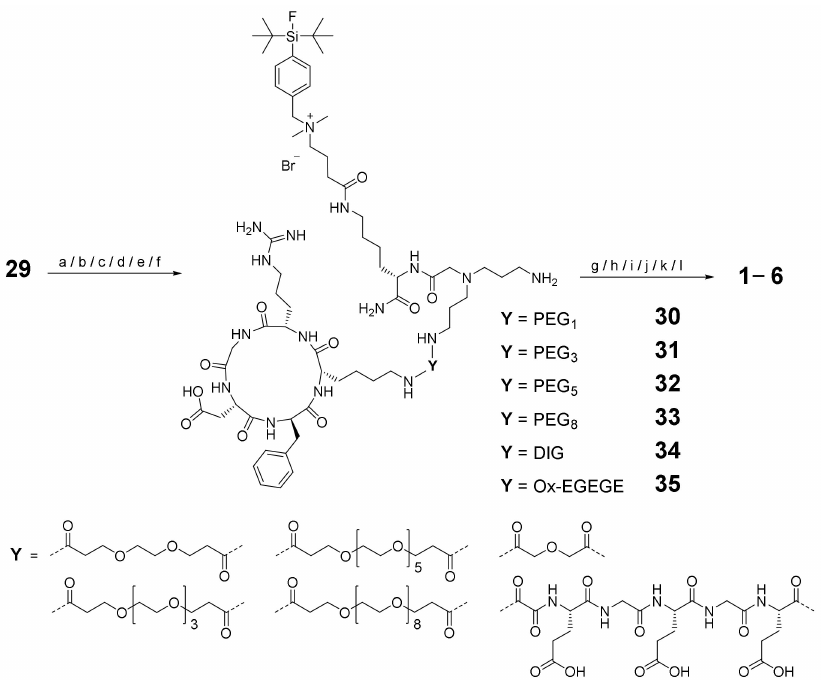
Scheme 5. Schematic depiction of the synthesis of the MC1R- and integrin α v β 3 -affine HBPLs 1 – 6